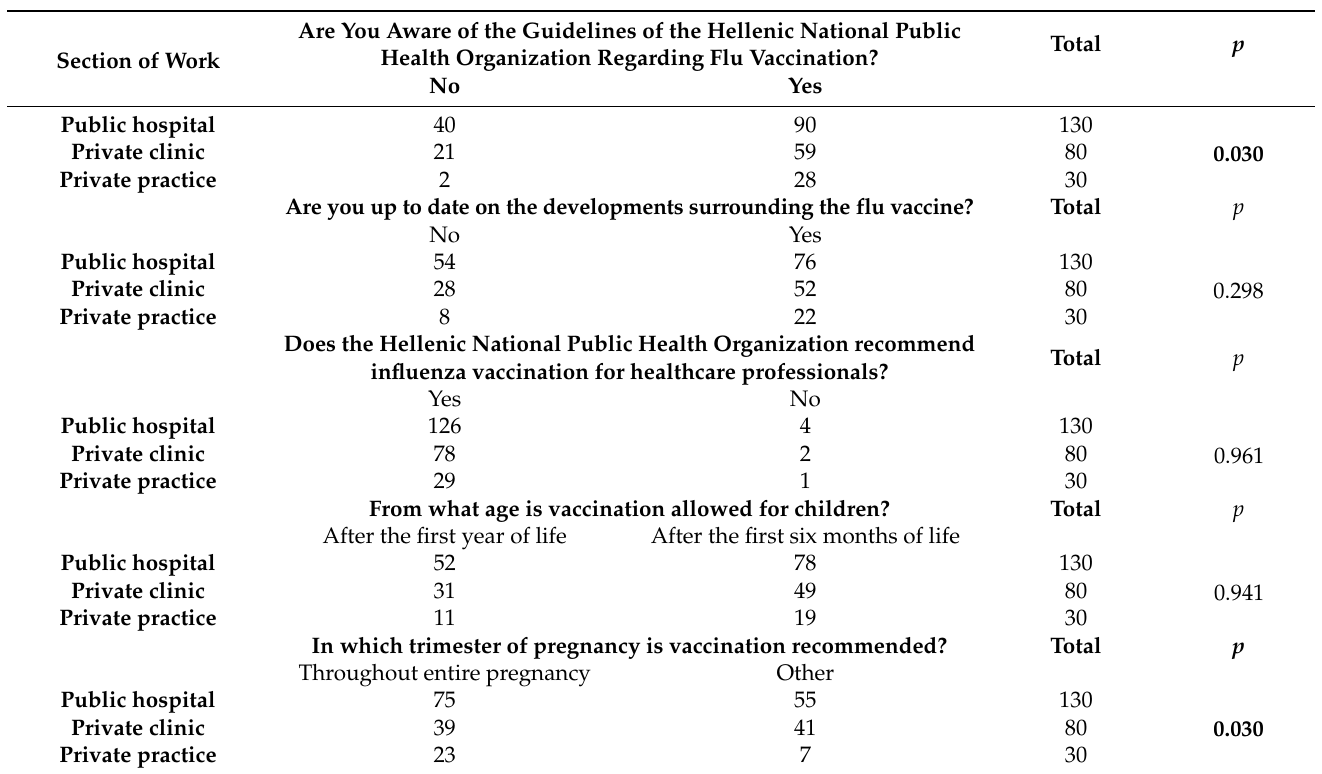
Figure 4. A statistically significant difference was observed in the proportion of participants who were vaccinated against the flu among the participants who recommended the vaccine (57.7% vaccinated vs. 42.3% unvaccinated, p = 0.01). Table 5. Associations of sections of work and years of service with knowledge about the flu